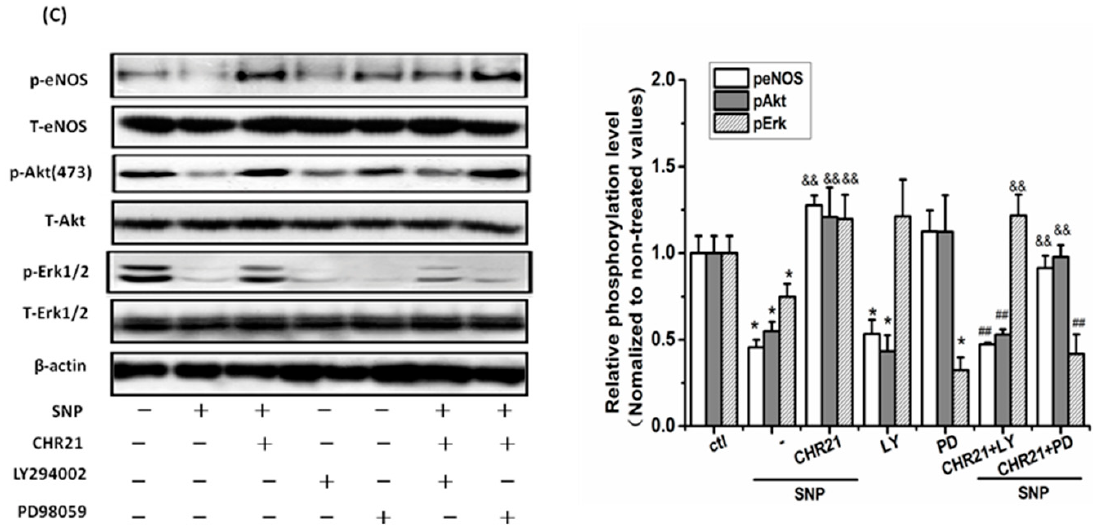
Figure 8. Both the PI3K/Akt/eNOS pathway and the ERK1/2 pathways were involved in the neuroprotective effects of CHR20/21 . Pre-incubation of LY294002, Akt VIII inhibitor, and PD98059 at a dose of 10 μ M, respectively blocked the neuroprotective effects of CHR20 ( A ) and CHR21 ( B ) in RGC-5 cells. MTT activity was determined by MTT assay. Each experiment was performed in triplicate. ## p < 0.01 vs. SNP group; ** p < 0.01 vs. CHR20/CHR21 + SNP group; & p < 0.05, && p < 0.01 vs. CHR20/CHR21 + PD group, or CHR20/CHR21 + LY group, respectively; ( C ) SNP inhibited the phosphorylations of Akt, eNOS and ERK1/2, respectively. And LY294002 and PD98059 reversed the effects of CHR21 . The density of each lane was presented as mean ± standard deviation for three individual experiments. * p < 0.05 vs. control group, && p < 0.01 vs. SNP group, ## p < 0.01 vs. CHR21 + SNP group. Blots were quantified using Image J software. Similar results were obtained with CHR20 (data not shown).